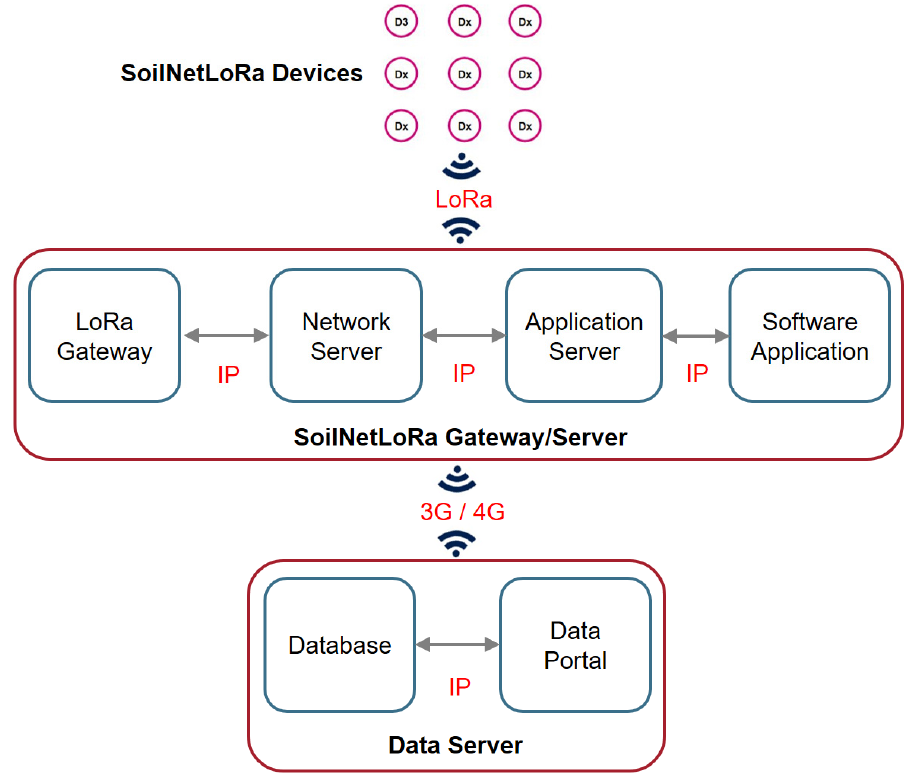
Figure 4. Principle of the LoRa network topology and its basic system architecture, as well as data communication types demonstrated using the example of the SoilNetLoRa wireless sensor network.